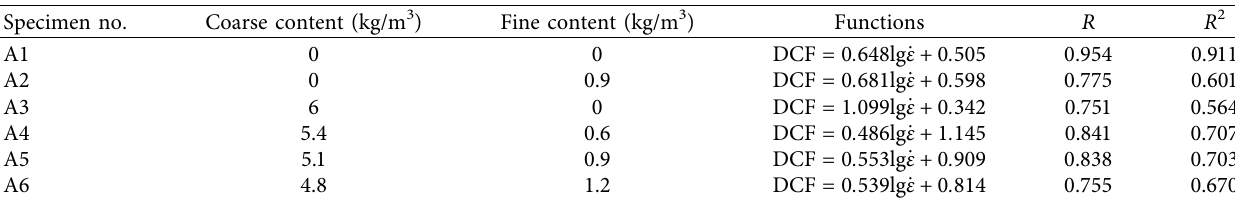
Table 5: Fitted DCF